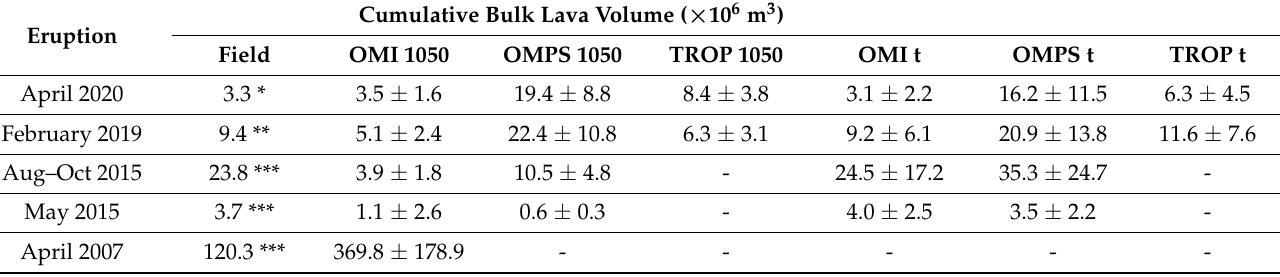
Table 4. Cumulative DRE volumes of erupted lava ( × 10 6 m 3 ) estimated from field measurements, MIROVA, and the reverse petrological approach using OMI, OMPS, and TROPOMI SO 2 data. “OMI/OMPS/TROP 1050” = pre-eruptive sulfur content within melt inclusions fixed at 1050 ppm; “OMI/OMPS/TROP t” = pre-eruptive sulfur content varies over time. Note that the MIROVA cumulative lava volume is expressed as a bulk volume and not a DRE